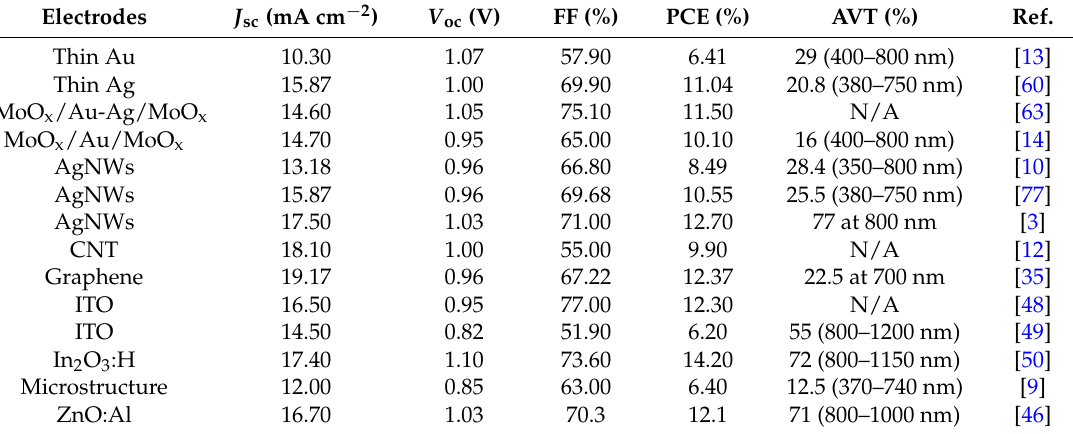
Table 1. Performance metrics of the semitransparent perovskite solar